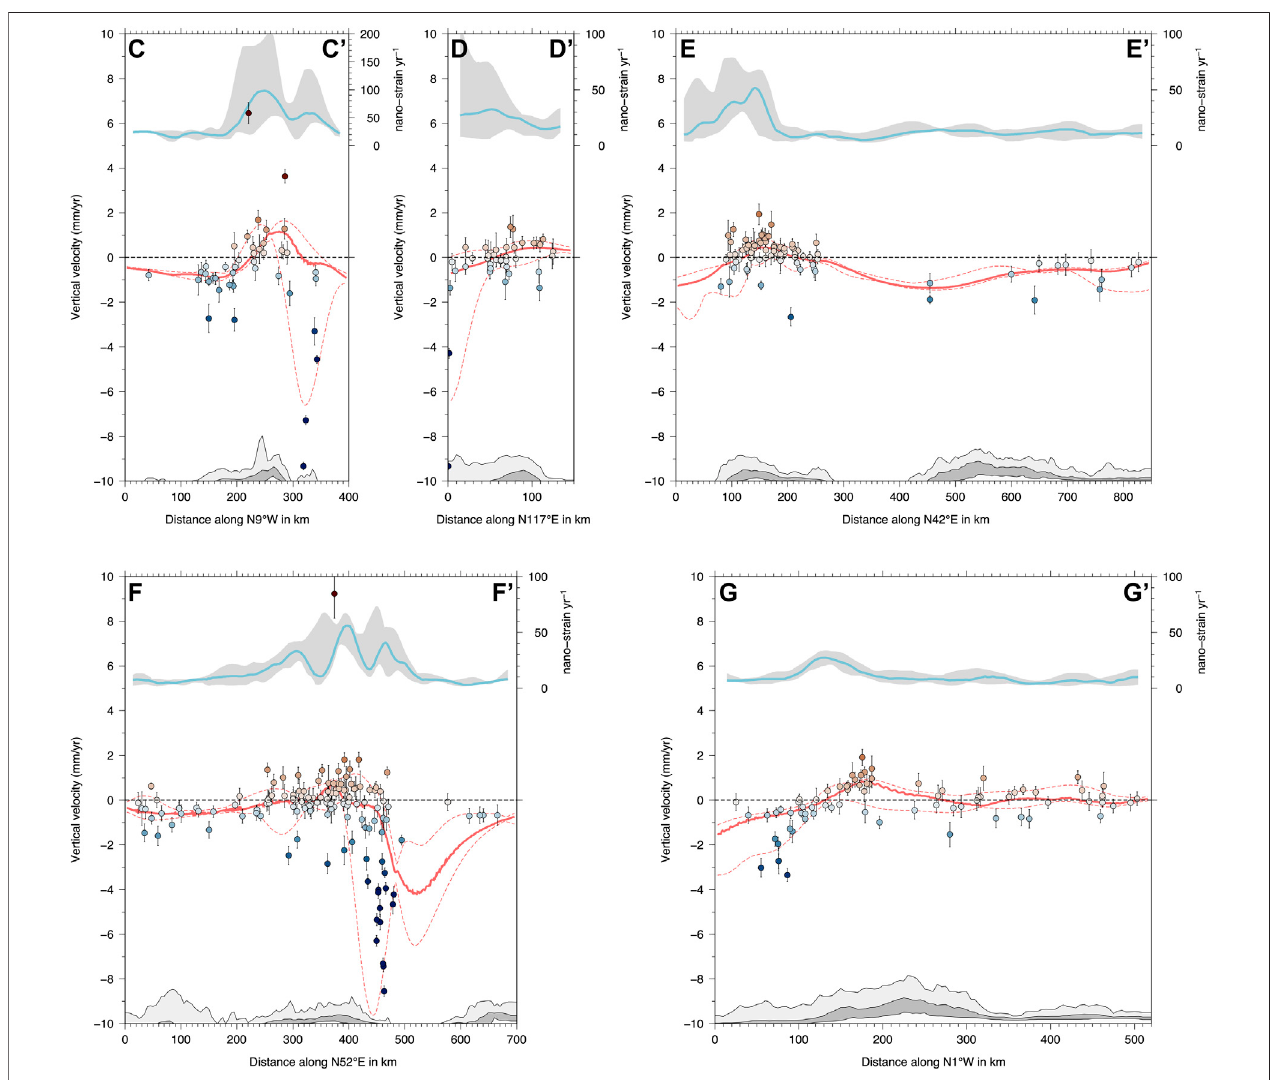
FIGURE 14 | Same as Figure 12 for cross sections in the Central Mediterranean (see Figure 9 ) across Sicily (2 – 2 ’ ), the Calabrian Arc (3 – 3 ’ ), the Southern Apennines and southern Dinarides (4 – 4 ’ ), the Northern Apennines and northern Dinarides (5 – 5 ’ ), the Western Alps (6 – 6 ’ ) and the Eastern Alps (7 – 7 ’ ).